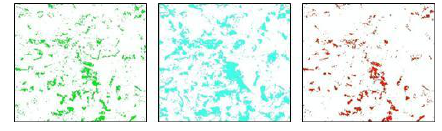
Fig 2. Change Information of Land Cover 2-(a) shows the snapshot of grass cover in 2000 2-(b) shows the snapshot of grass cover in 2010 2-(c) shows the decreased grass from 2000 to